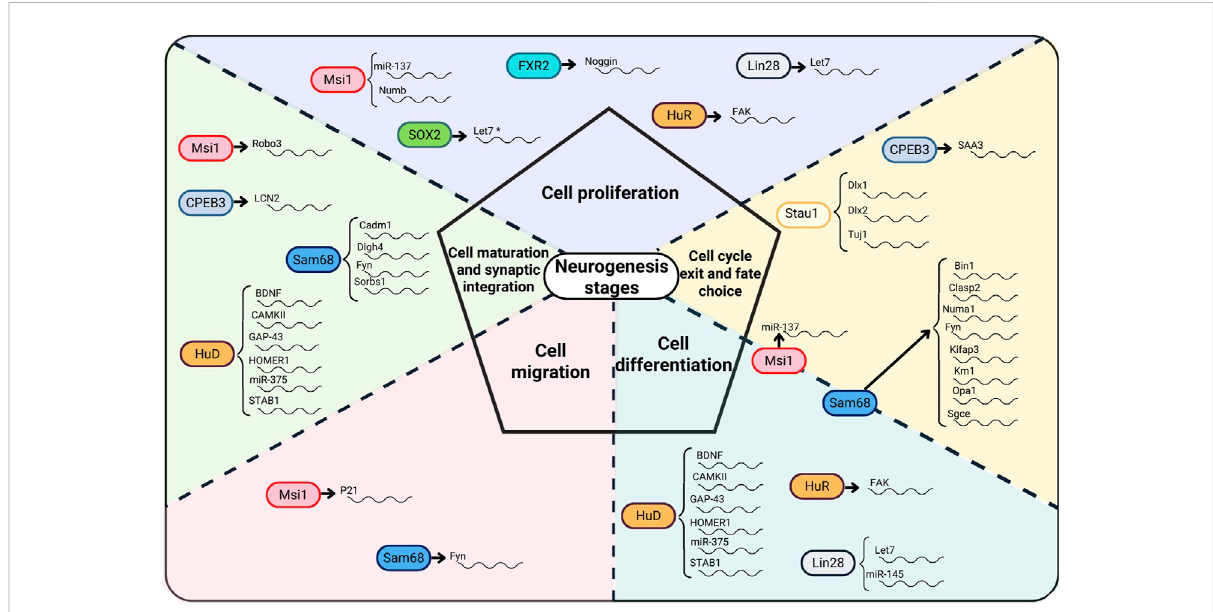
FIGURE 1 RBPs, their RNA targets, and the role of RBPs at different neurogenesis stages. RBPs acting on different stages of the neurogenesis process appearonthedottedlinesoftheneurogenesis stagesthat theyregulate.InSOX2,*indicatesanindirectinteraction withlet7asSOX2suppressesthe expression of let7 expression by maintaining Lin28 expression.